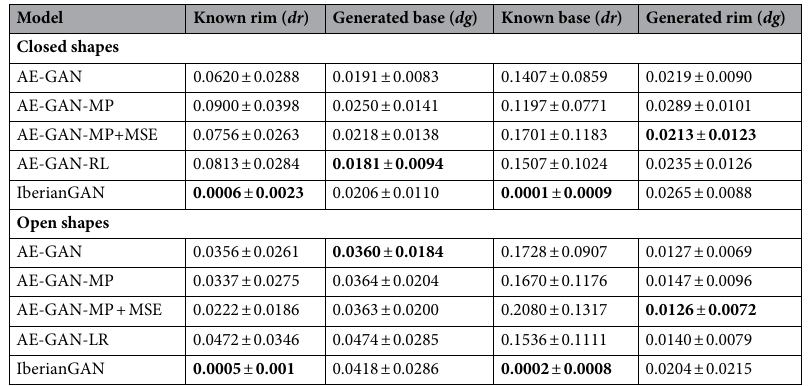
Table 2. Euclidean distances in morphometric spaces for open and closed Iberian pottery shapes. The best value per metric are in